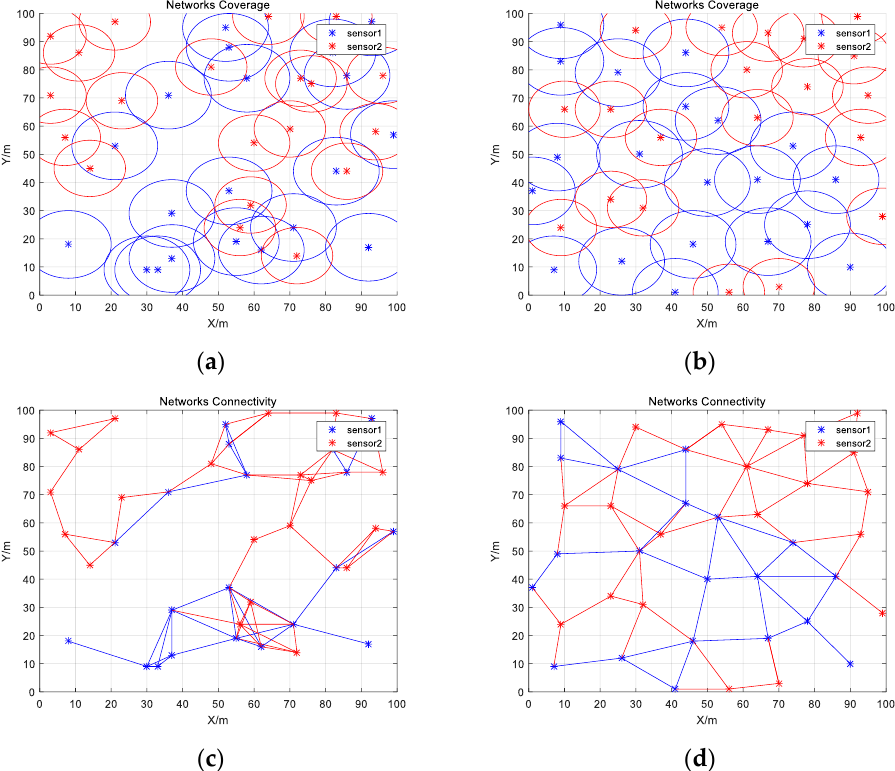
Figure 8. Coverage and connectivity map of sensors. ( a ) Initial coverage map of sensors; ( b ) Opti- mized coverage map of sensors; ( c ) Initial connectivity map of sensors; ( d ) Optimized connectivity map of sensors. Table 15. Comparison of HWSN coverage optimization experimental results.